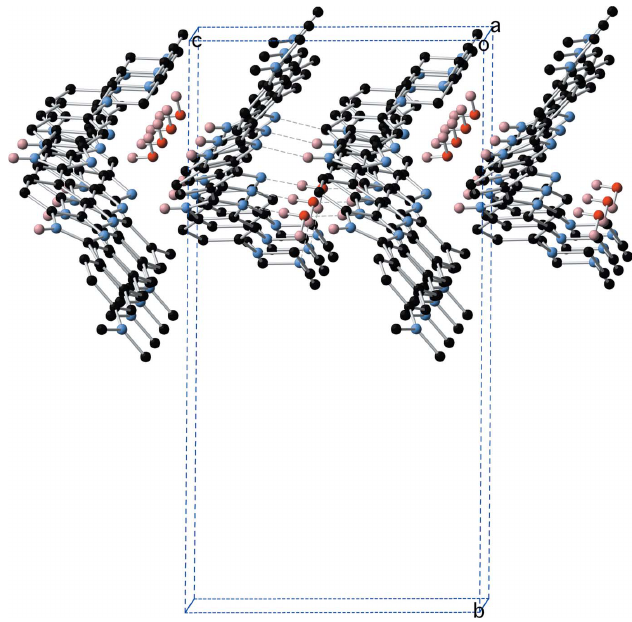
Figure 10 Two-dimensional hydrogen-bonded network in (1) (cid:2) H 2 O.